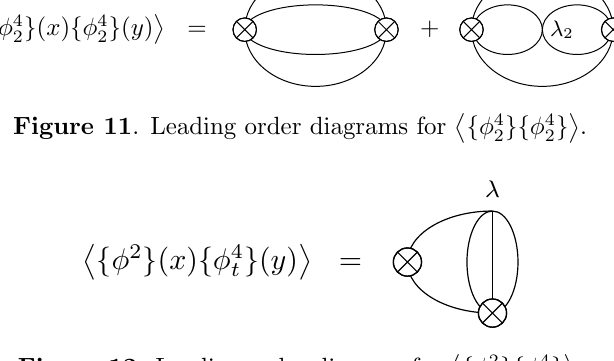
Figure 12 . Leading order diagram